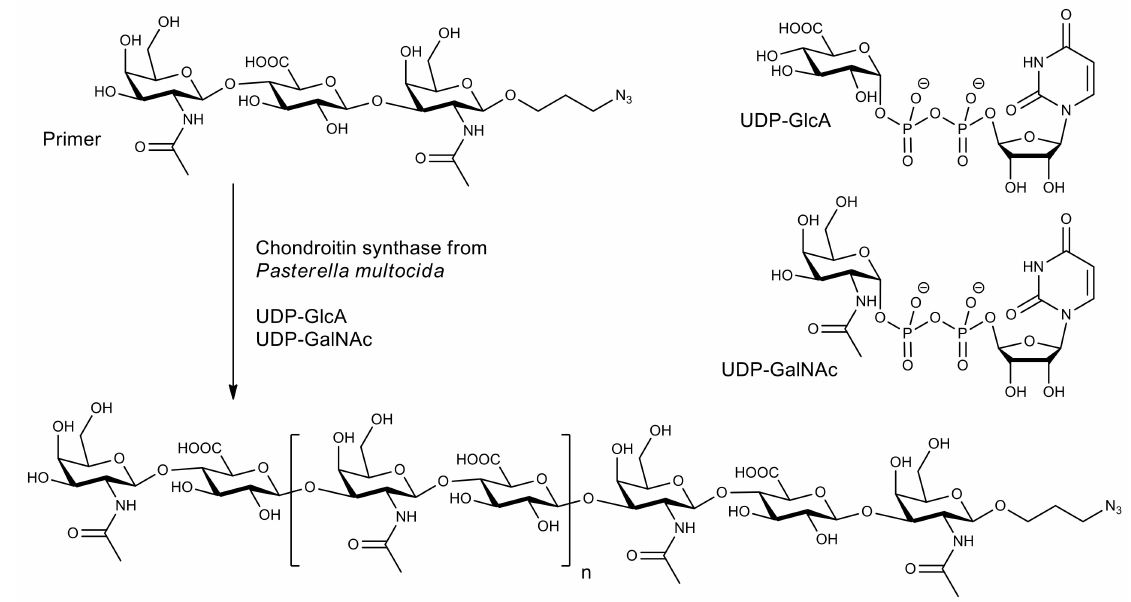
Figure 5. Scheme of biocatalytic preparation of a chondroitin polymer from a trisaccharide primer and monomers UDP-GlcA and